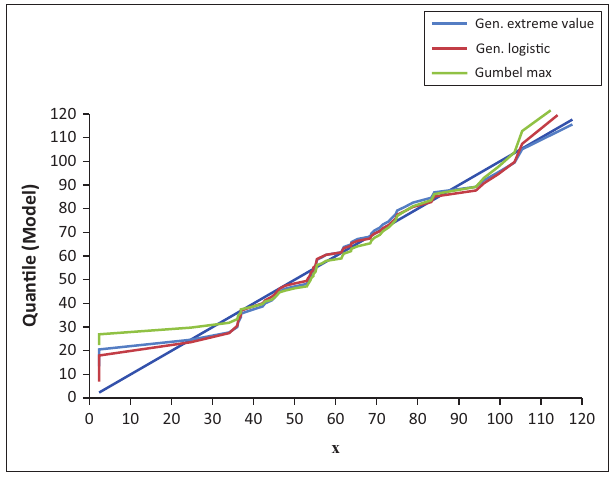
FIGURE 4: Quantile–quantile plot of annual maximum daily rainfall events for Nelspruit